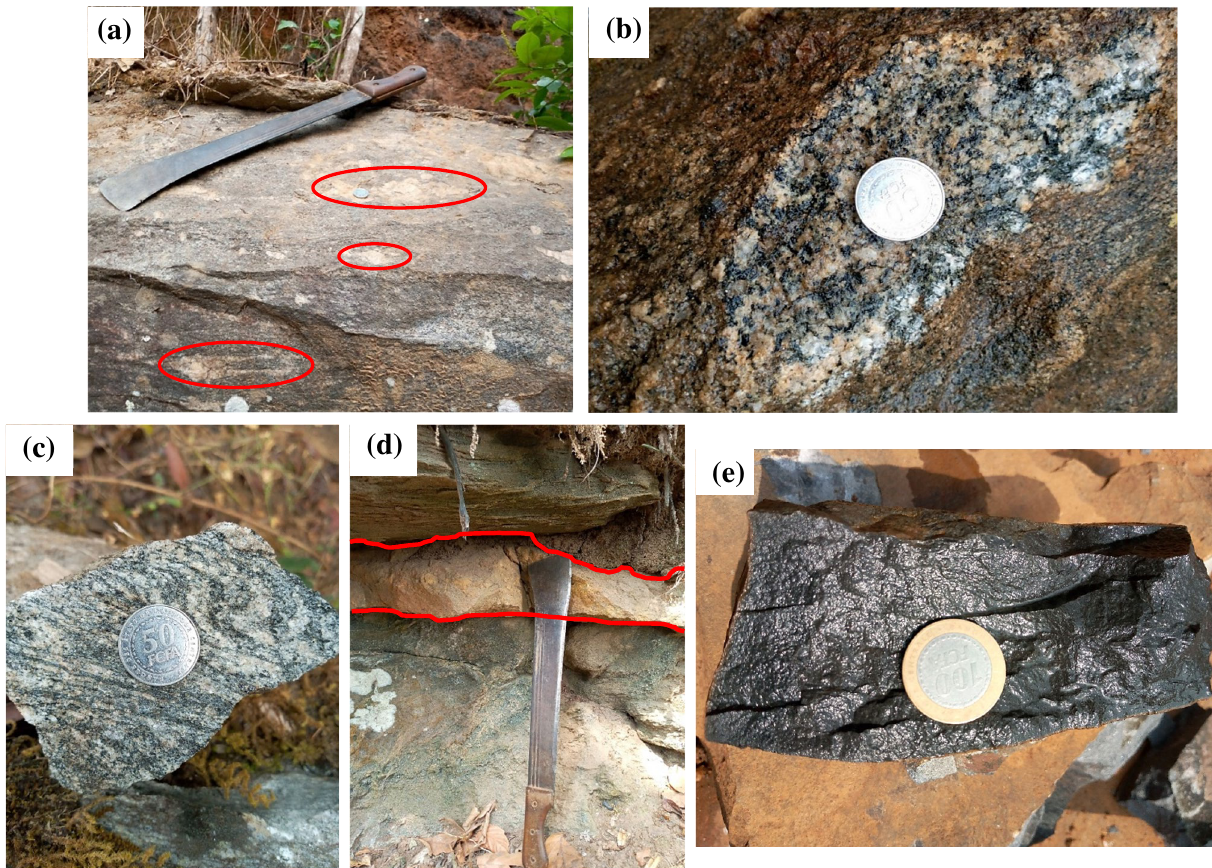
Fig. 5 a Sub outcrop of Augen gneiss. Ellipses on plate shows Auga. b Granite samples making up the study area. c Gneiss showing milli- metric folds. d Ten (10) cm thick pegmatite intruding in a gneiss. ( e )